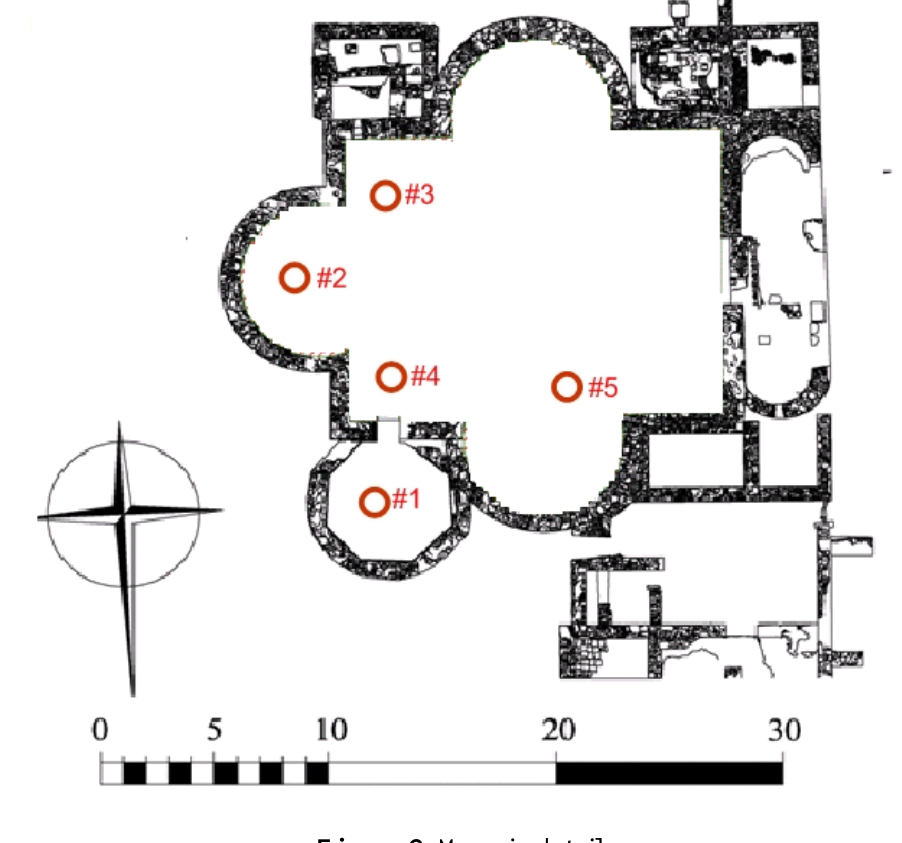
Figure 1. Plan of the archaeological site showing the location of sensors.